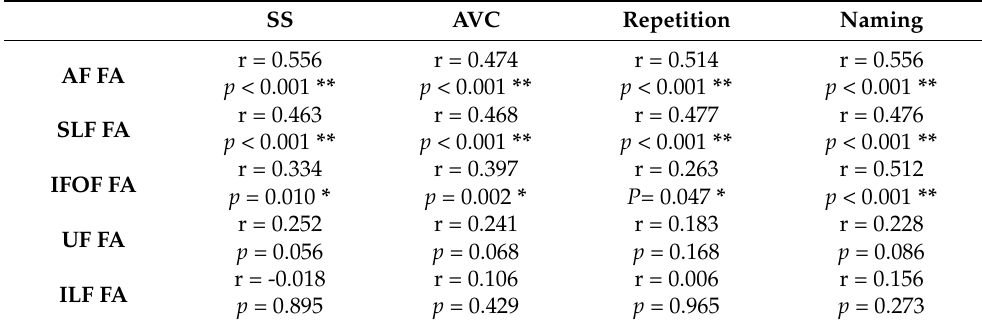
Table 3. Correlations between LRWM parameters and WAB